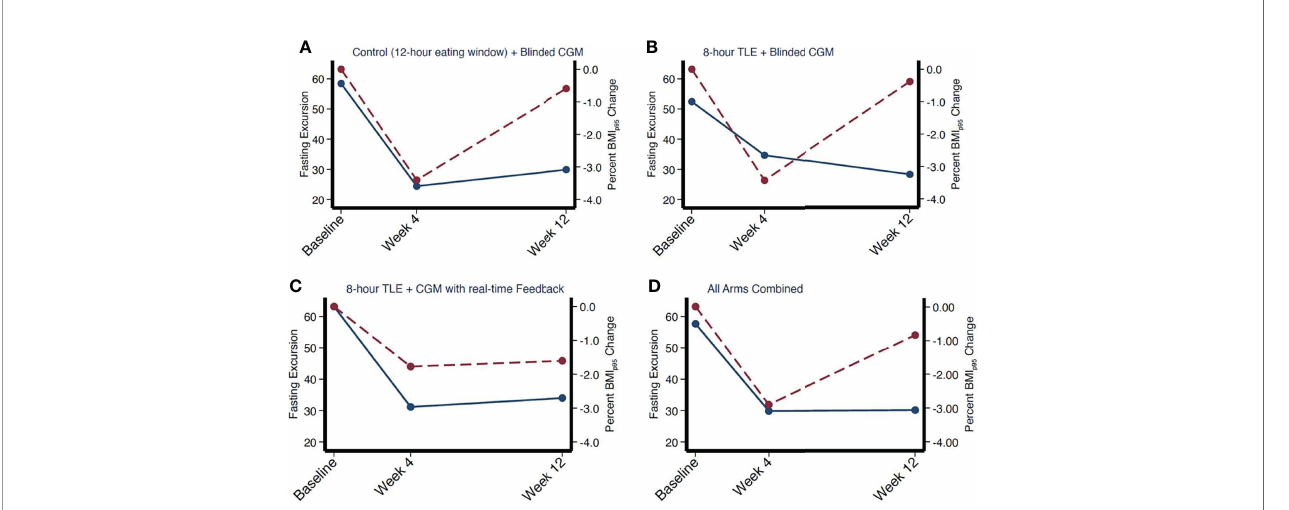
FIGURE 3 | Correlation between mean fasting excursion and weight change over time by intervention arm (A – C) and combined (D) . Fasting excursion denoted by red dotted line. Weight change denoted by solid blue